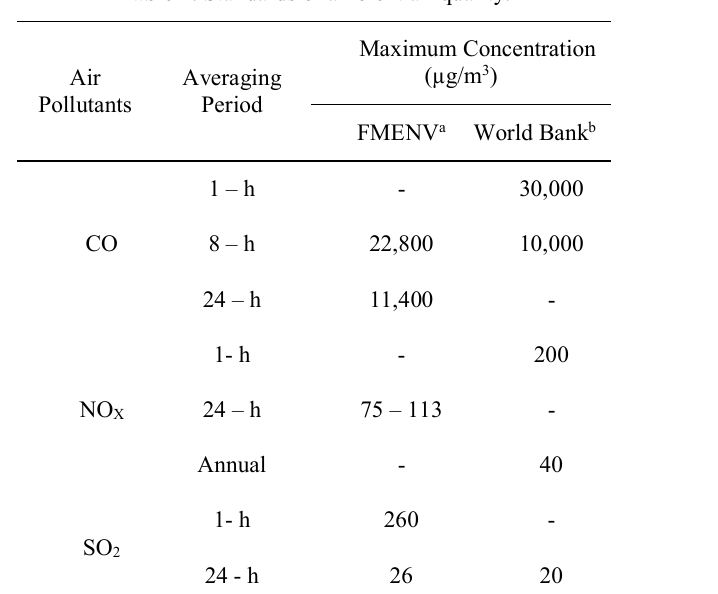
Table 1. Standards of ambient air quality.